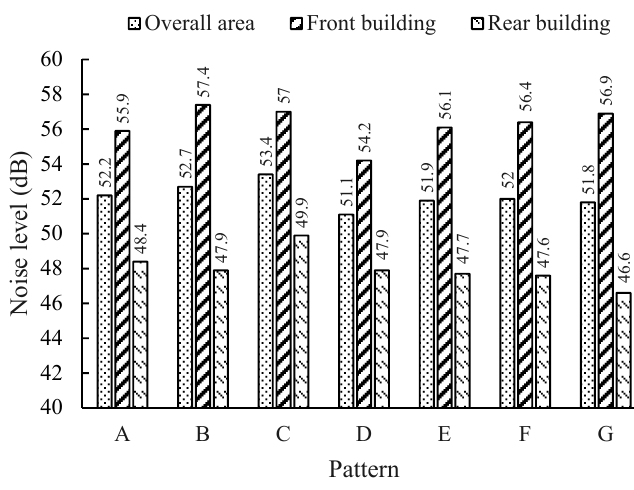
ff erent patterns (in